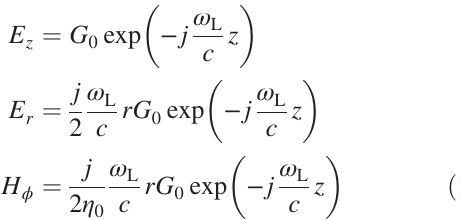
group gr ) loaded cylinder. r geo